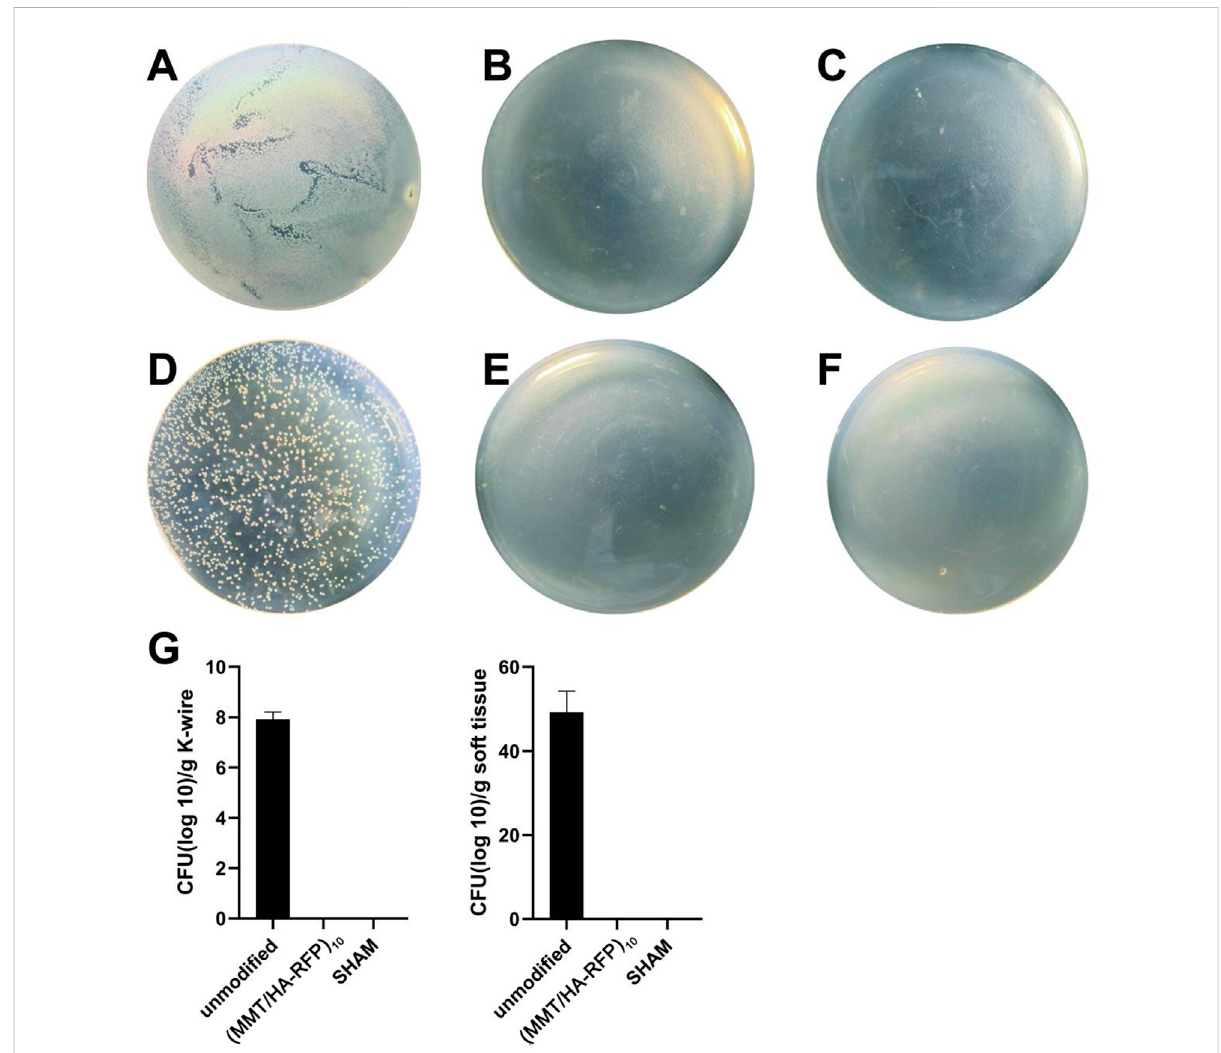
FIGURE 8 Colonies from K-wires: (A – C) unmodi fi ed, (MMT/HA-RFP) 10 , and sham groups, respectively. Colonies from soft tissue: (D – F) unmodi fi ed, (MMT/HA-RFP) 10 , and sham groups, respectively. (G) Number of colonies in each